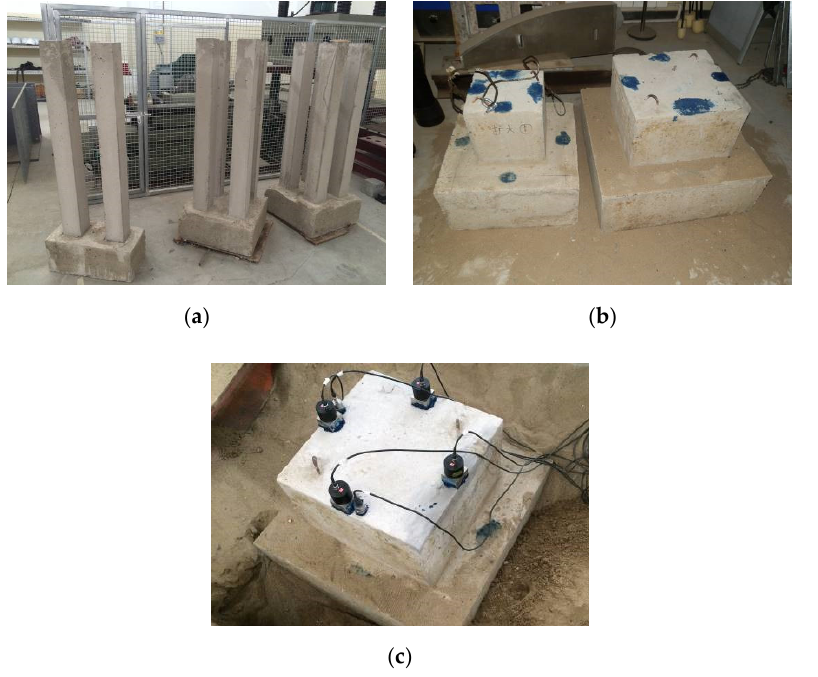
Figure 3. Pictures of the various model foundations: ( a ) grouped pile foundation models; ( b ) spread foundation models; ( c ) caisson foundation model and its sensor locations.